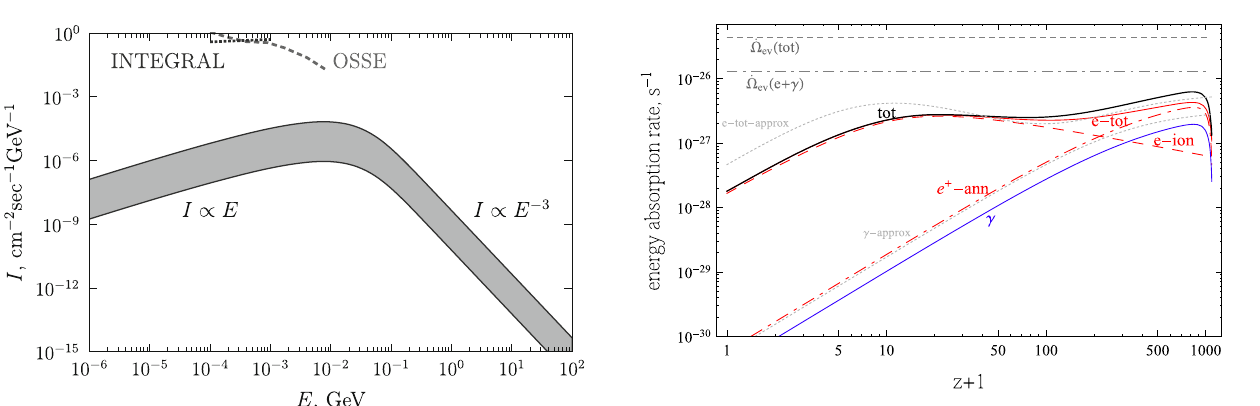
Fig. 11 The expected gamma-ray spectra from PBH clusters (the shaded region). Below the shaded region the flux from PBH is lower than LAT integral sensitivity. Above it, too few clusters are expected to be observed as PGRS, namely less than one (see the text for more details). The differential sensitivity of detectors INTEGRAL and OSSE is also shown